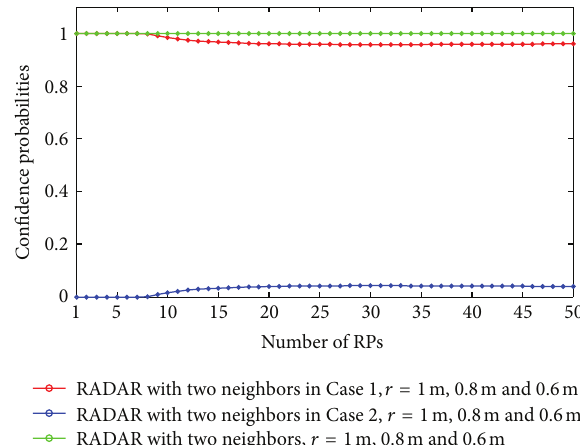
Figure 5: Confidence probabilities by two-neighbor matching